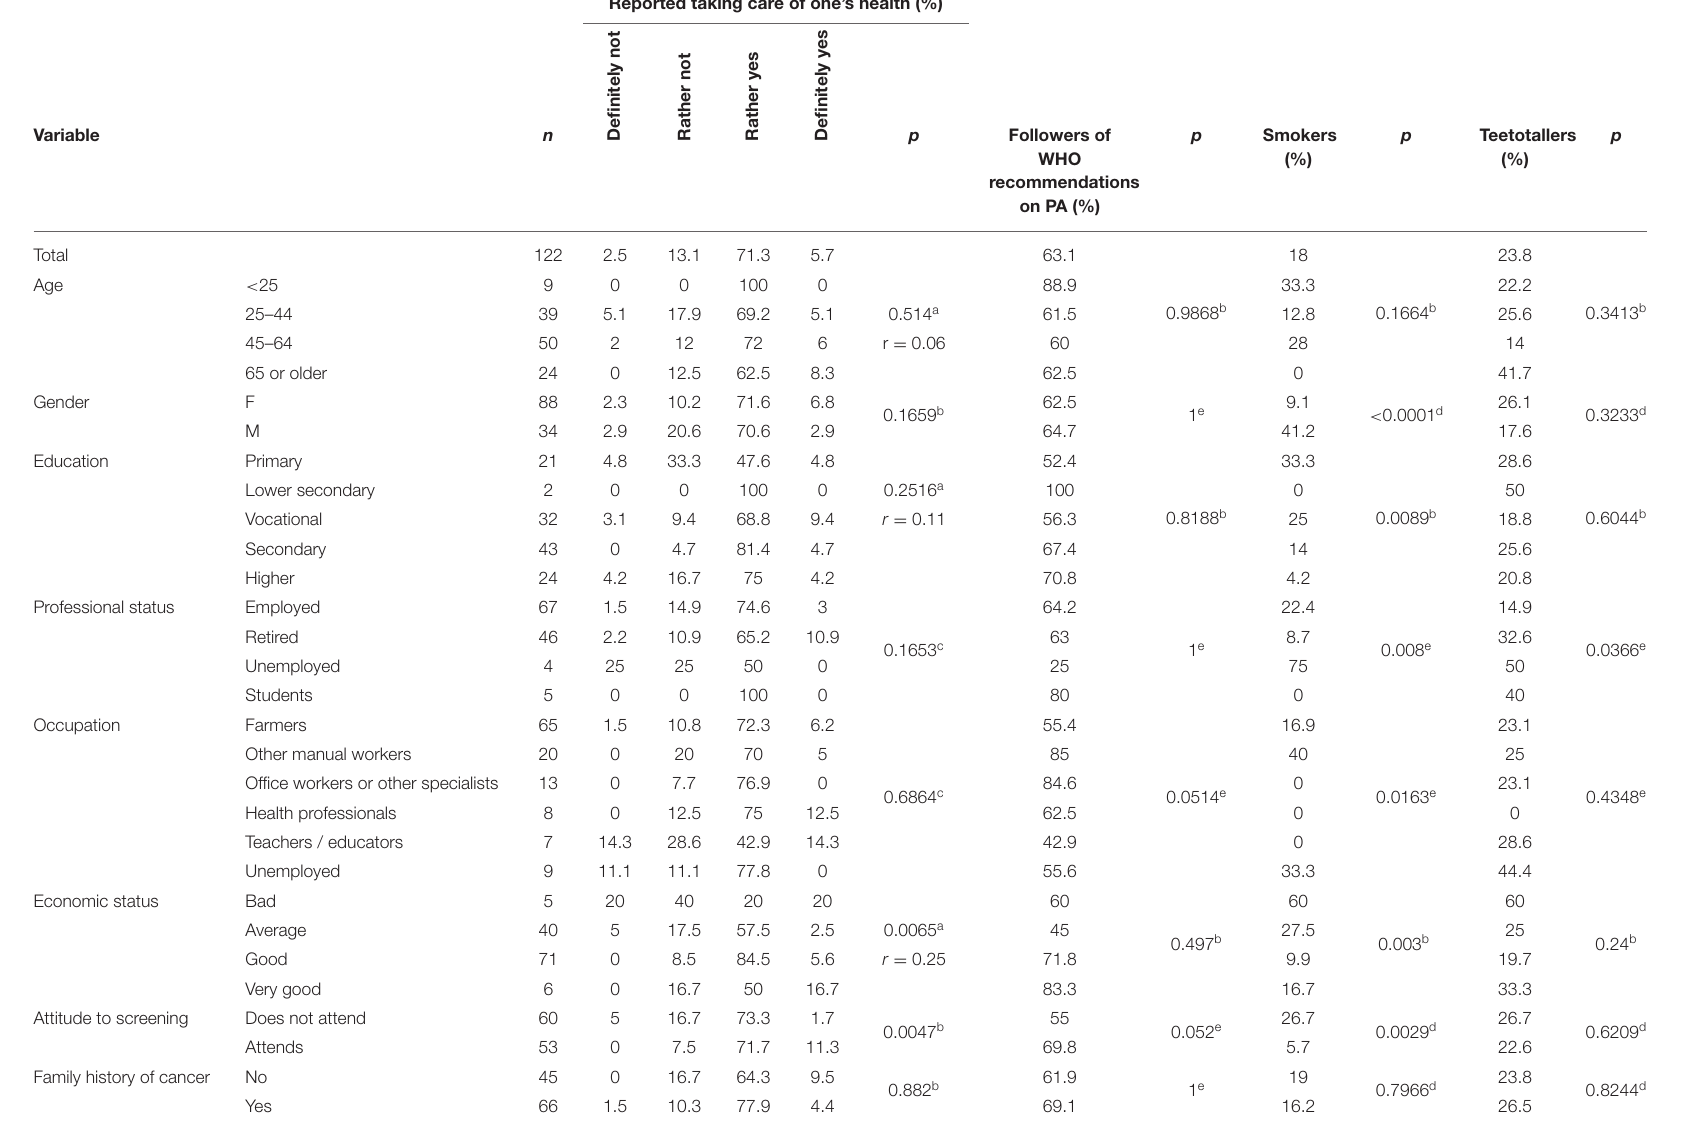
TABLE 5 | The reported taking care of one’s health and selected health behaviours ( n =